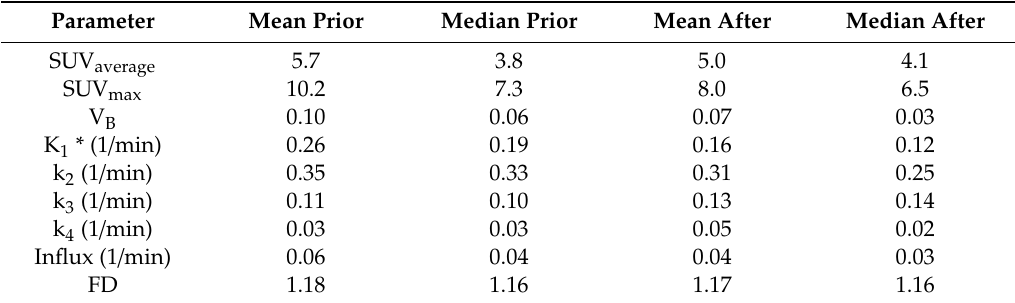
Table 3. Descriptive statistics of mean and median values prior and after pazopanib therapy for the 18 F-FDG semi-quantitative and quantitative parameters in STS. The values of parameters K 1 , k 2 , k 3 , k 4 and influx are 1/min. SUV values, blood component (V B ), and fractal dimension (FD) have no units.